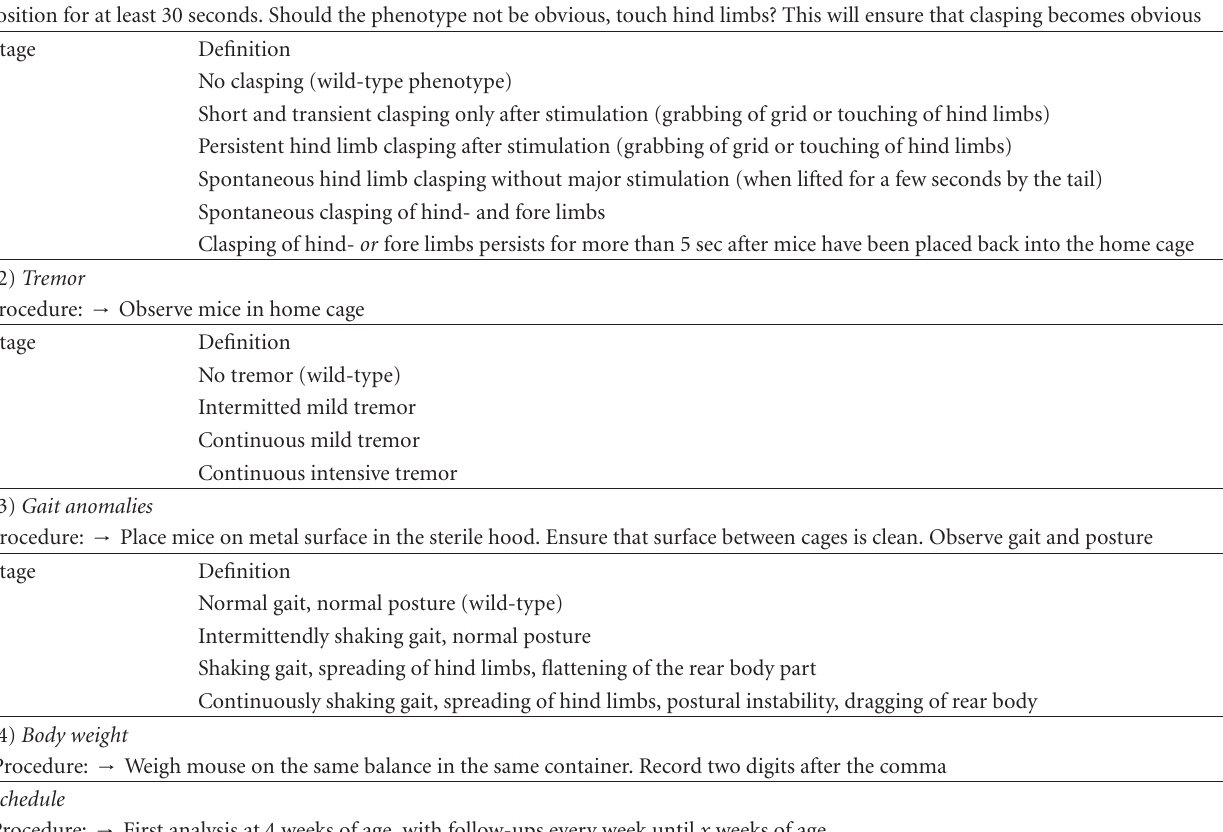
Table 1: Phenotyping protocol for ENU/K3 mice. Four phenotypes are being scored, limb clasping, tremor, and gait abnormalities (cardinal features defining Parkinsonism) and body